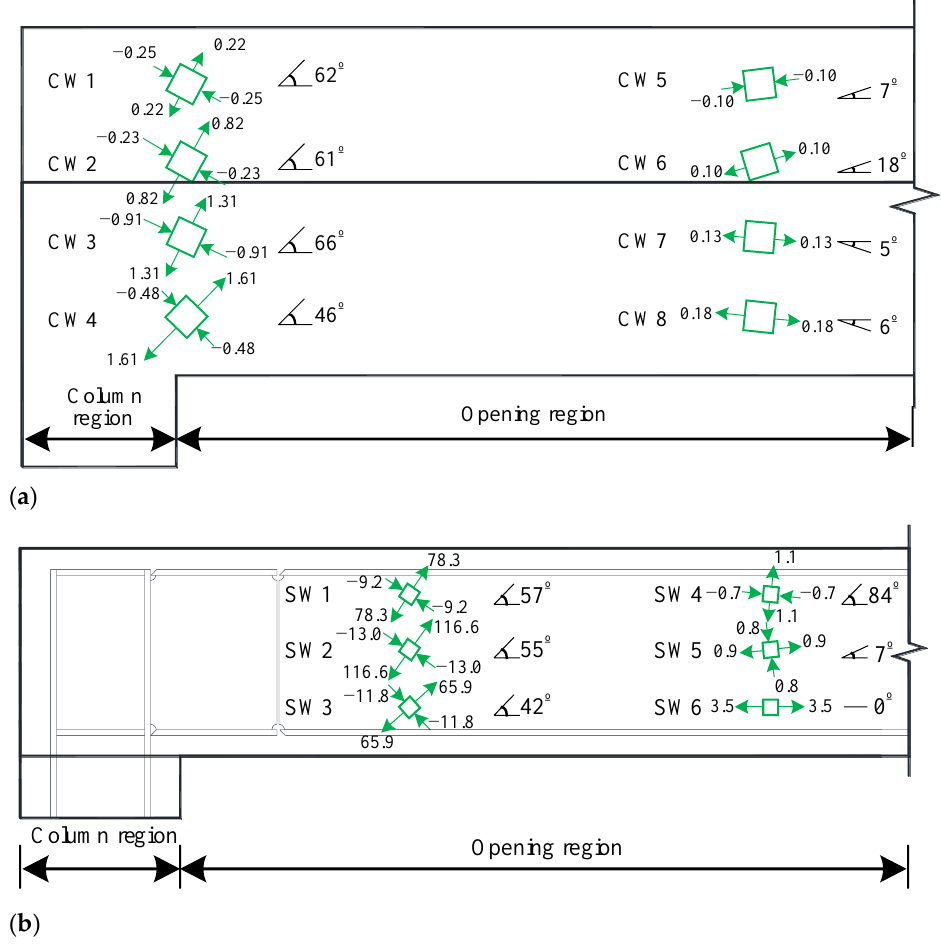
Figure 15. Stress distribution of the SRC beam (units: N/mm 2 ): ( a ) stress distribution of the concrete before cracking and ( b ) stress distribution of H-steel in the last loading stage.